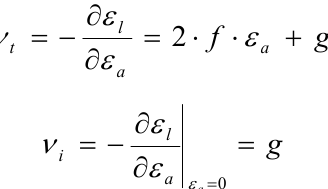
Figure 10. Failure ratio R